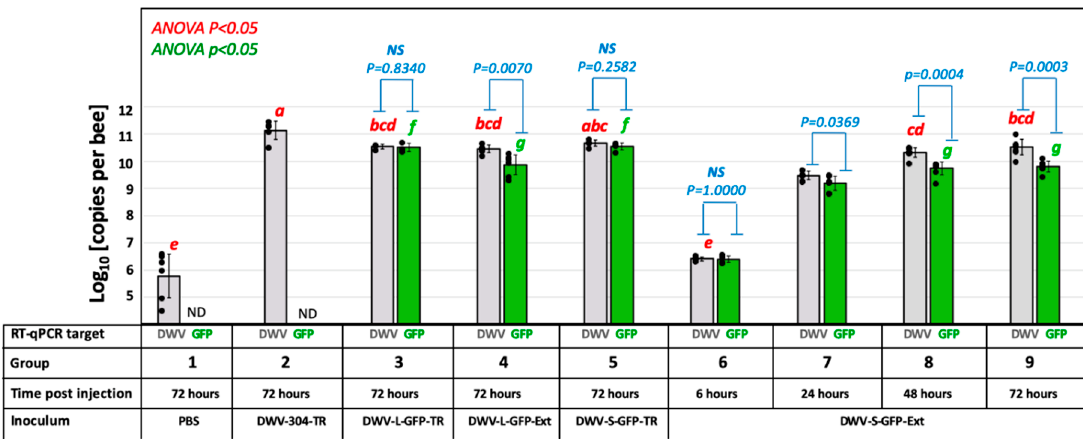
Figure 2. Replication of the GFP-tagged DWV in honey bee pupae. Average copy numbers of DWV and GFP RNA per pupa revealed by RT-qPCR are shown as the light grey and green graphs, respectively, the error bars show ± standard deviation (SD), black dots show DWV RNA or GFP RNA copy numbers in individual pupae. Treatments are shown below the graphs; Inocula: PBS—phosphate buffered saline; suffix -TR, in vitro RNA transcript; suffix -Ext, filtered extract from the pupae infected with the corresponding in vitro RNA transcript. Red letters above the bars indicate significantly and non-significantly different groups (ANOVA, P < 0.05). Blue bars—the statistical significance of the DWV and GFP copy numbers within the same group NS—non-significant (ANOVA P > 0.05).